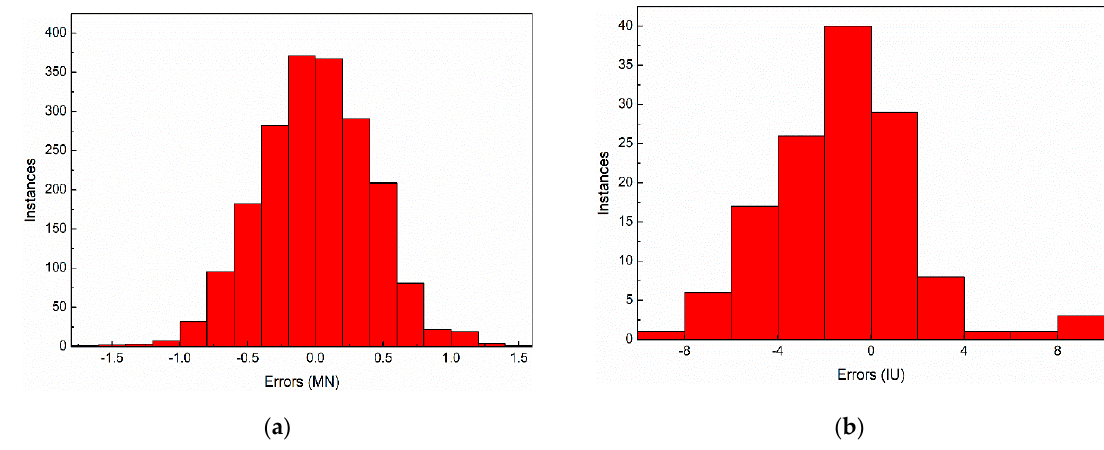
Figure 8. The error distribution histogram of ( a ) rolling force and ( b ) strip flatness. Table 1. The error indexes of rolling force and strip flatness.